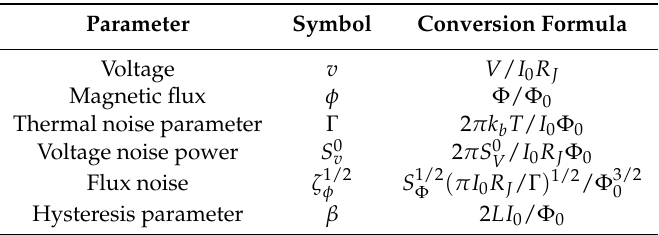
Table 1. Dimensionless